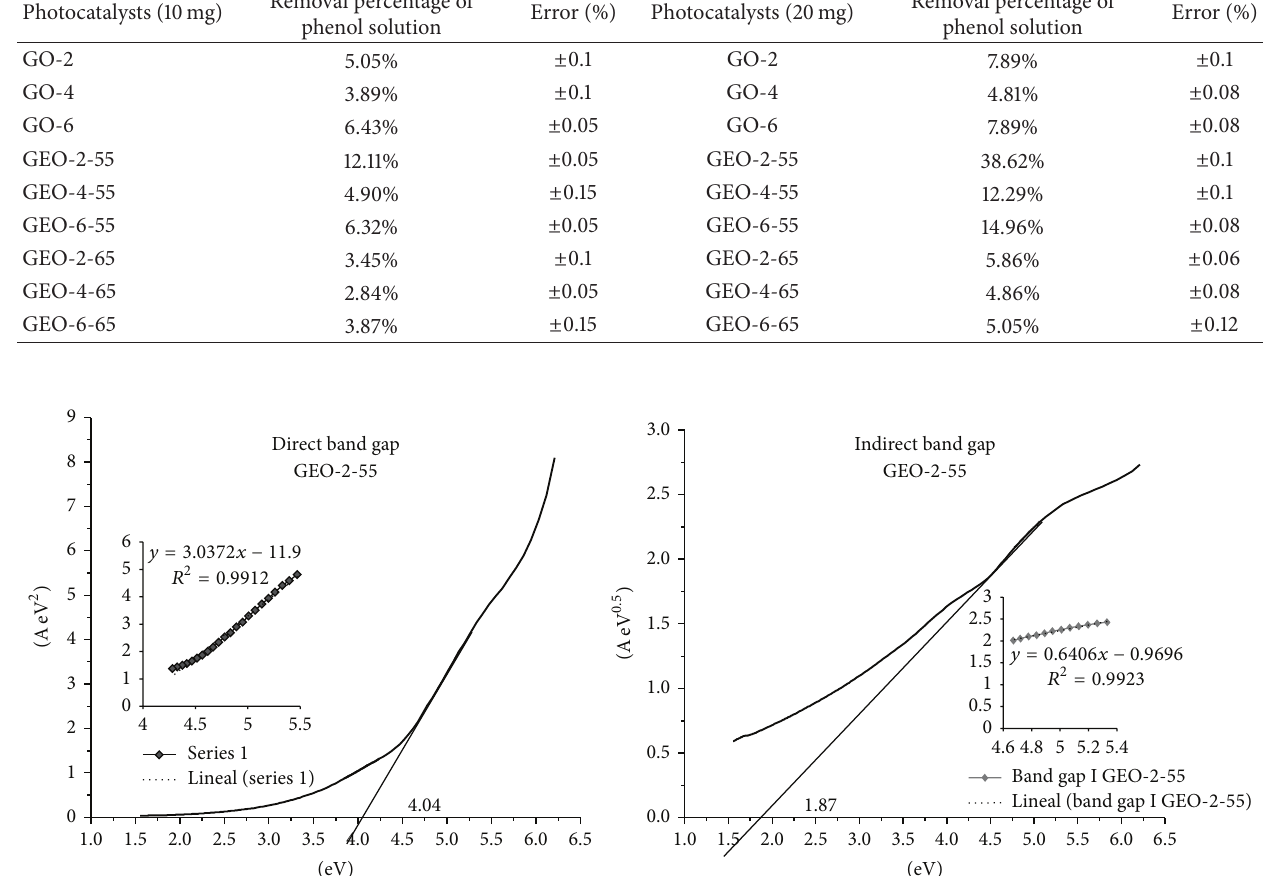
exactly the same, in spite of the encapsulated air, because the photocatalyst plays a prominent